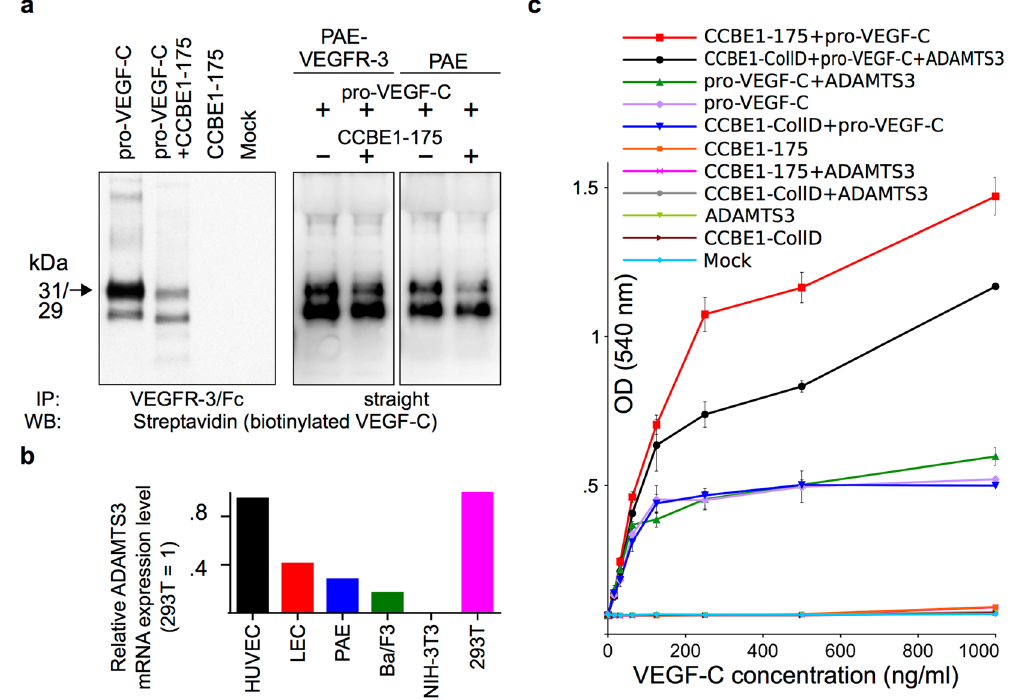
Figure 5. The N-terminal domain of CCBE1 affects the distribution and activity of pro-VEGF-C in cell-based assays. ( a ) VEGFR-3-expressing PAE cells were exposed to biotinylated pro-VEGF-C with and without the N-terminal domain of CCBE1 (CCBE1-175). Analysis of the supernatant after the incubation shows a marked reduction in the amount of pro-VEGF-C when incubated together with CCBE1-175. In the left panel, the leftover VEGF-C in the supernatant was immunoprecipitated with soluble VEGFR-3 receptor (VEGFR-3/ Fc) before analysis. Note that only the upper band of pro-VEGF-C is subject to depletion. ( b ) Comparison of expression levels of ADAMTS3 by quantitative PCR. Expression levels of different cell types were normalized to 293 T cells. Note that all tested cell lines except for NIH-3T3 cells express ADAMTS3 to some degree. Two different primer pairs gave similar results (data is shown for primer pair 1). ( c ) Recombinant CCBE1-175 increases the effect of pro-VEGF-C on Ba/F3-hVEGFR-3/EpoR cells compared to pro-VEGF-C alone or a mixture of pro-VEGF-C and the C-terminal domain of CCBE1 (CCBE1-CollD). Increasing the amounts of ADAMTS3 by adding ADAMTS3-conditioned medium renders this assay also sensitive for the detection of CCBE1-CollD activity. Note that all five controls are superimposed. The full length blots are shown in Supplementary Fig.